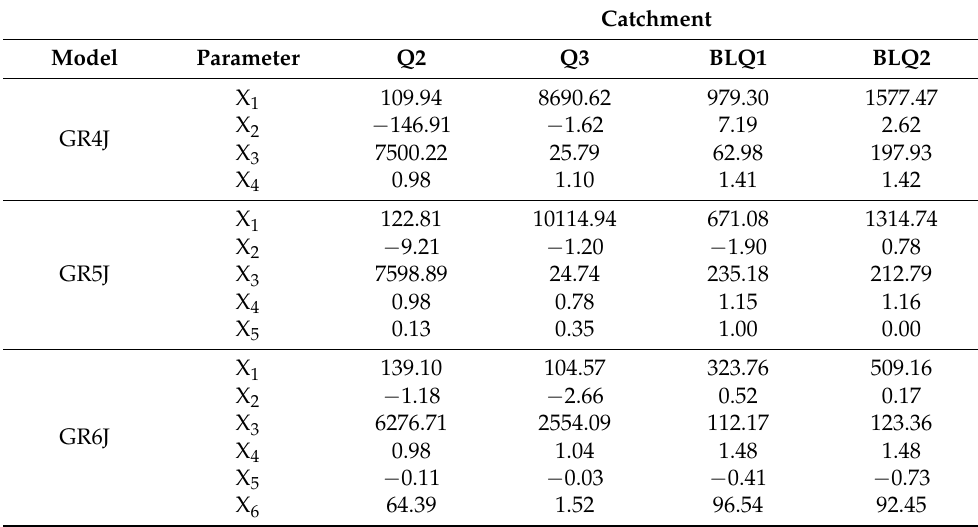
Table 3. Parameter sets that maximize flow simulation efficiency in each basin for GR4J, GR5J and GR6J hydrologic models in calibration